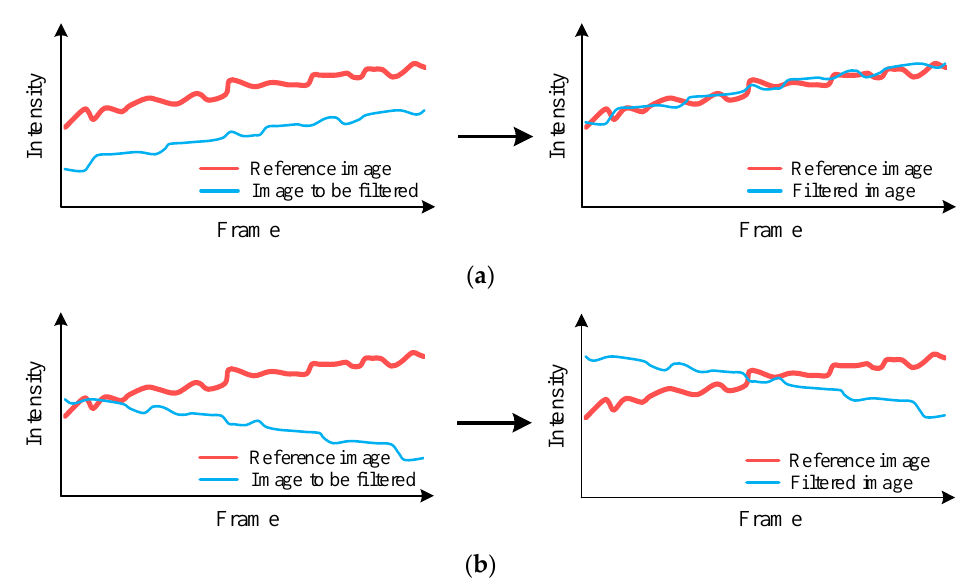
Figure 3. The intensity distribution trends along the stitching seam of two images before and after classic Wallis filtering. ( a ) The situation of similar trends; ( b ) the situation of opposite trends.